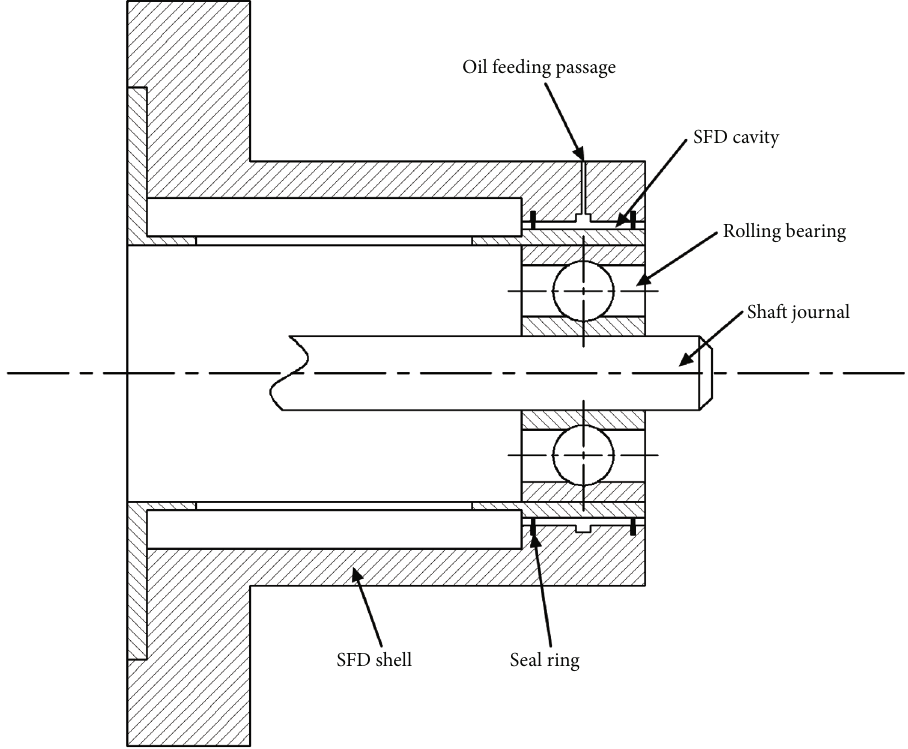
Figure 1: Typical structure of the SFD and squirrel cage